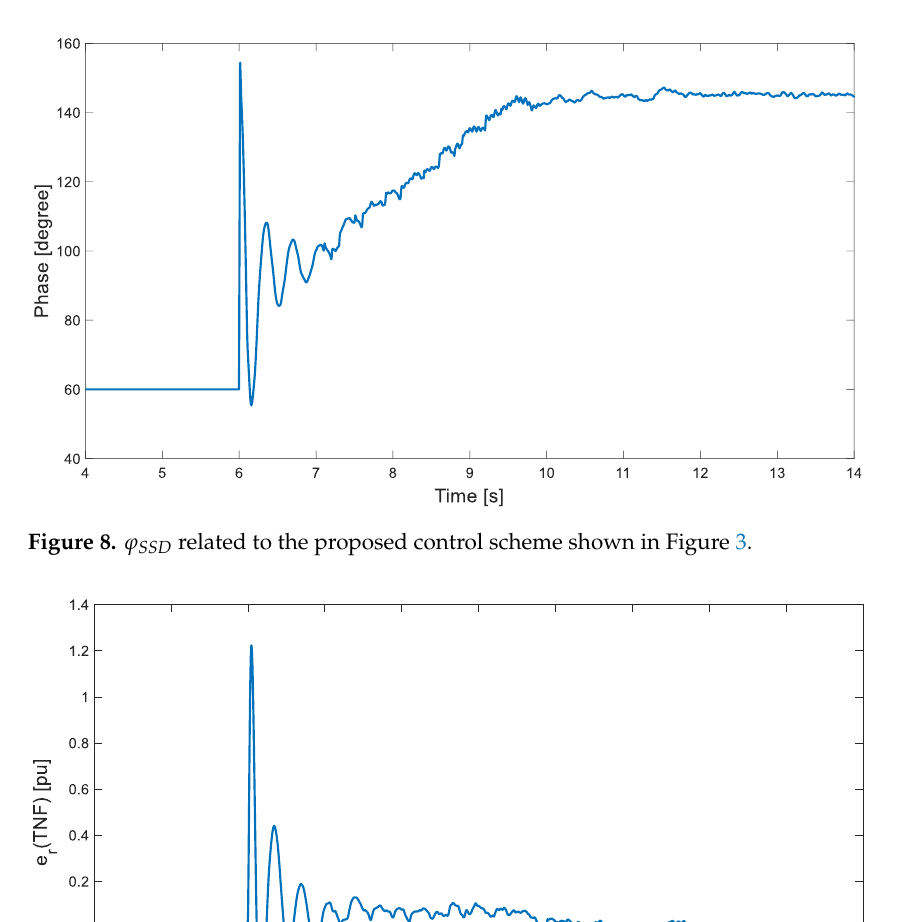
i  obtained by applying the proposed control method D a m p